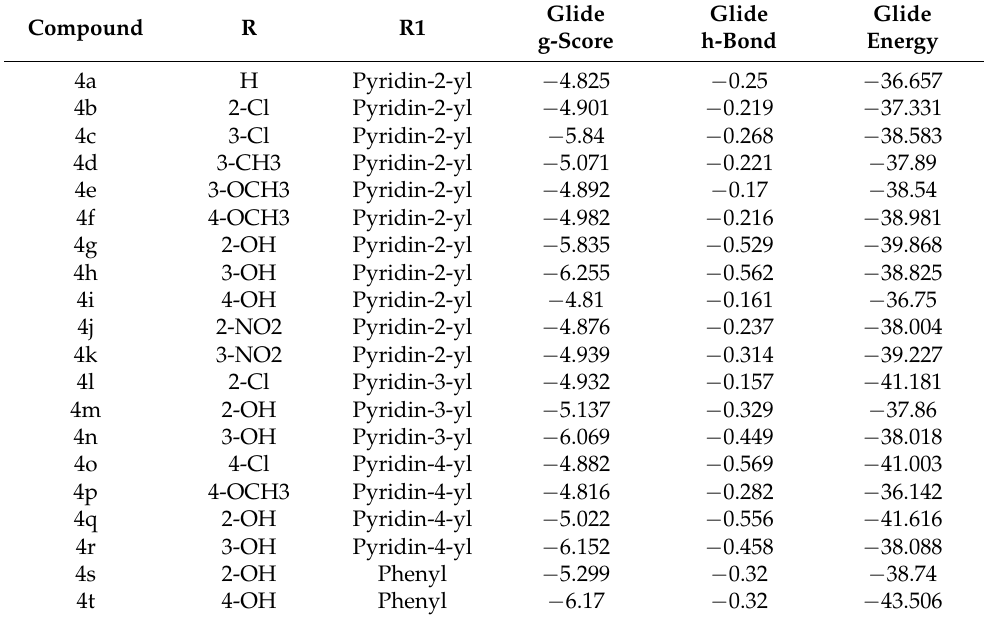
Table 1. Docking results of the selected